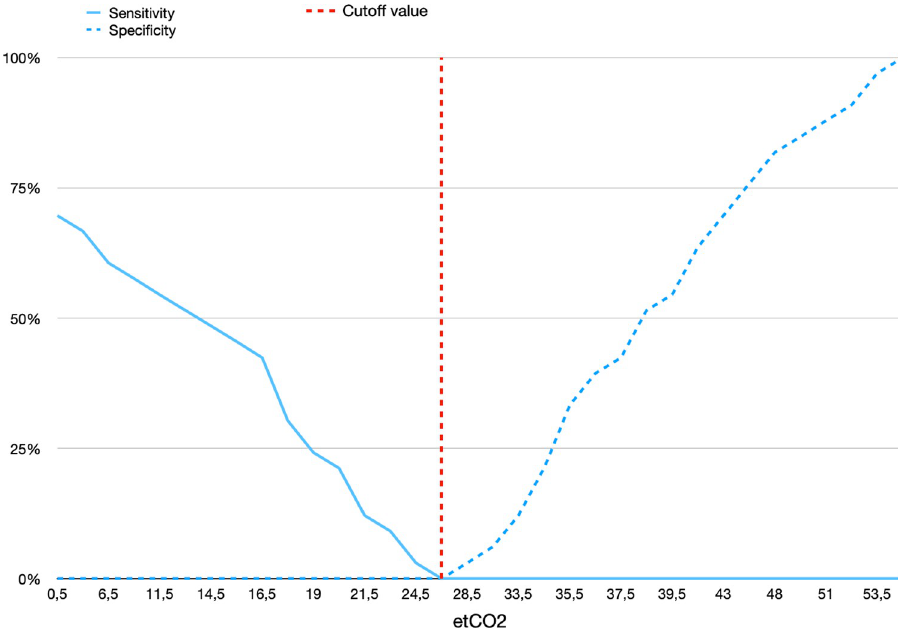
Fig 6. Cumulative distribution analysis of ETCO 2 detection. Performed to exclude the NGT tracheal misplacement. The red line indicates the cutoff limit according to Youden Index (J = 1).